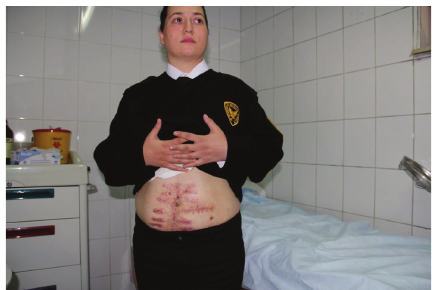
Figure 10: After 10 months optimum abdominal closure was achieved and there is no